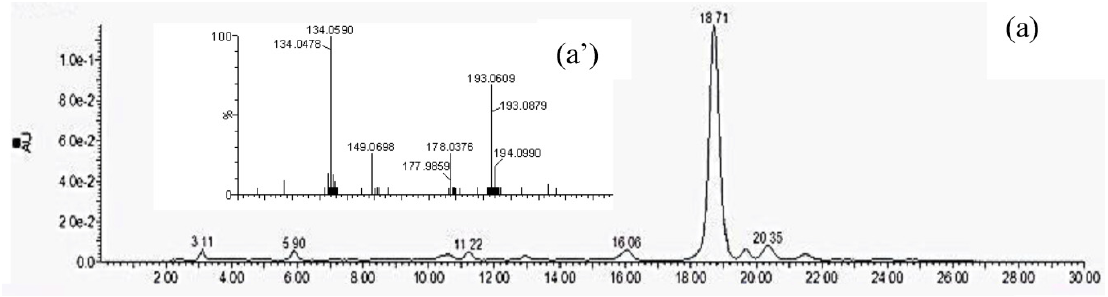
Figure 2. HPLC chromatograms of extracts of bound ferulic acid in the ( a ) flour sample and ( b ) bread sample and LC-MS/MS spectra of the ( a’ ) flour sample and ( b’ ) bread